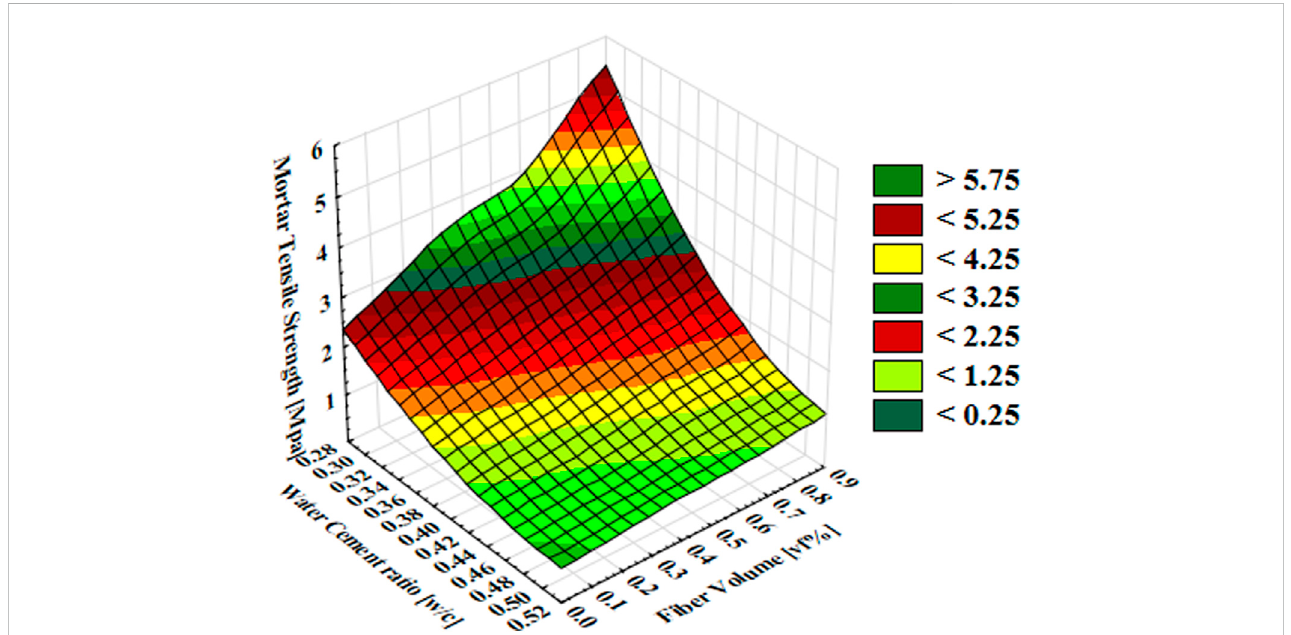
FIGURE 4 Mortar tensile strength, MPa against fi bre-volume fraction, V f (%) and water-cement (w/c) ratio.